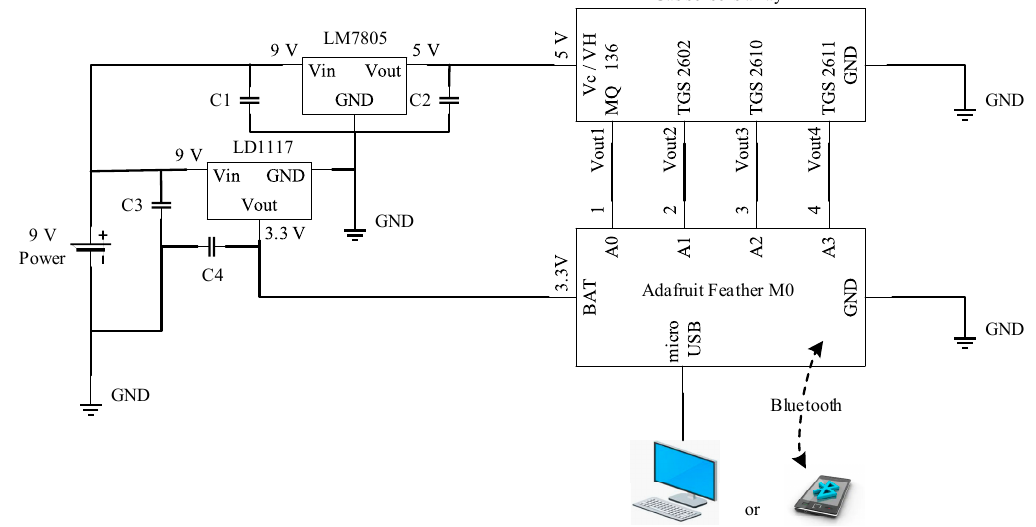
Figure 4. Schematic of the microcontroller-based signal acquisition system.